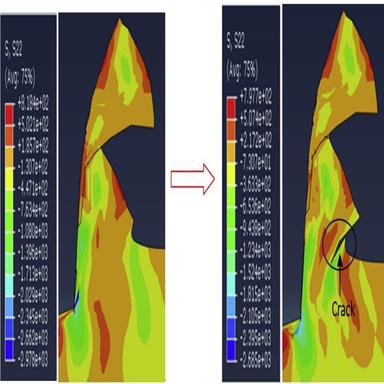
Variation of stress state (Stress unit: Mpa).